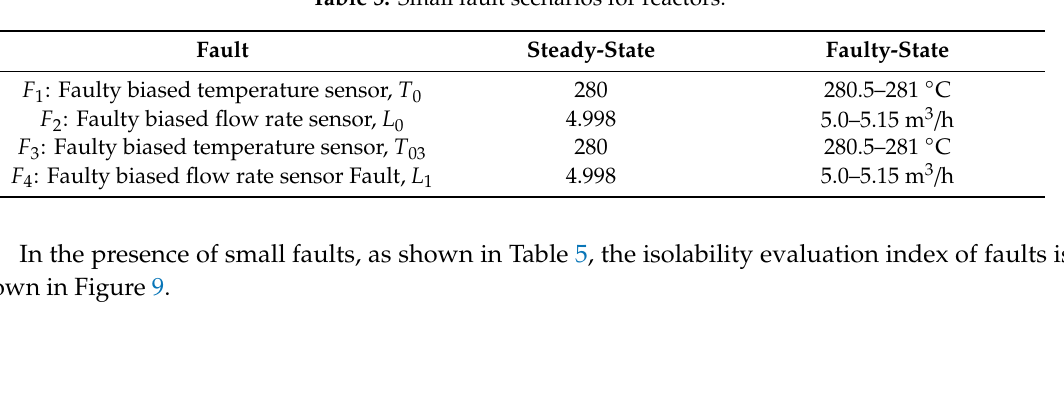
Table 5. Small fault scenarios for